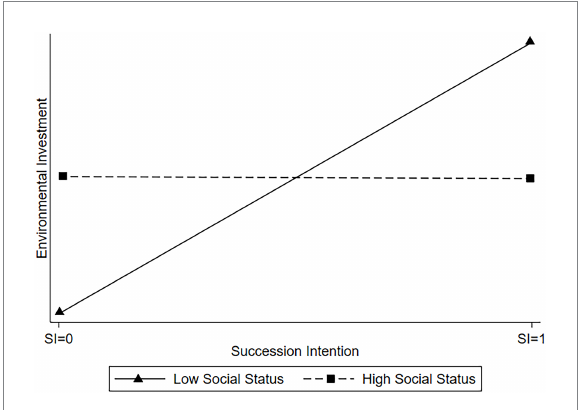
FIGURE 1 The moderating effects of founders’ subjective social